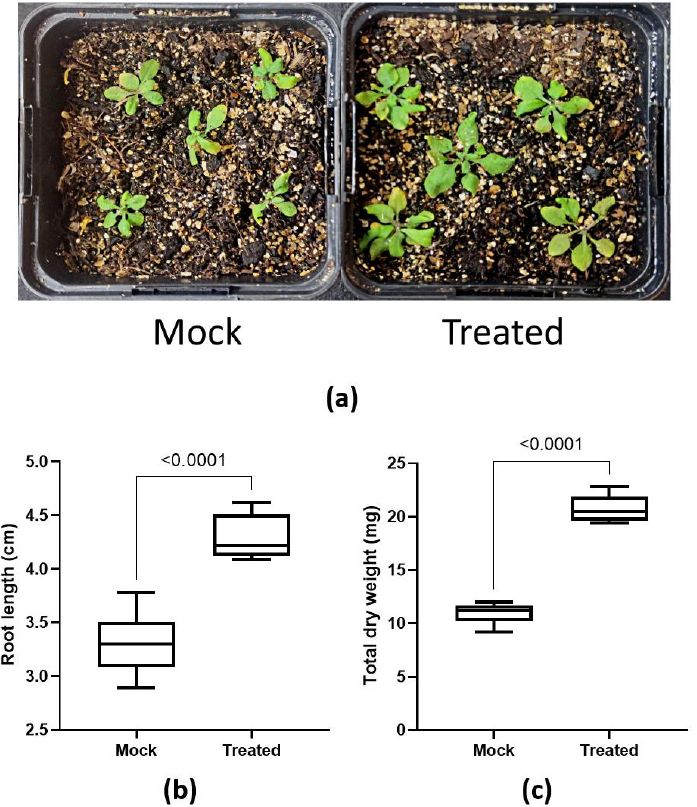
Figure 1. Plant growth promotion test. ( a ) The picture shows the 9 DAT phenotype of seedlings under ‘Mock’ (control) and ‘Treated’ conditions; ( b , c ) boxplot graphs record the main root length ( b ) and dry weight of the whole plant ( c ). Four independent experiments (each one with n = 5 biologically independent samples) were prepared in this test. Whiskers represent the minimum to maximum data range, and the median is represented by the central horizontal line. The upper and lower limits of the box outline represent the first and third quartiles. Error bars represent s.d., including p -value when they were